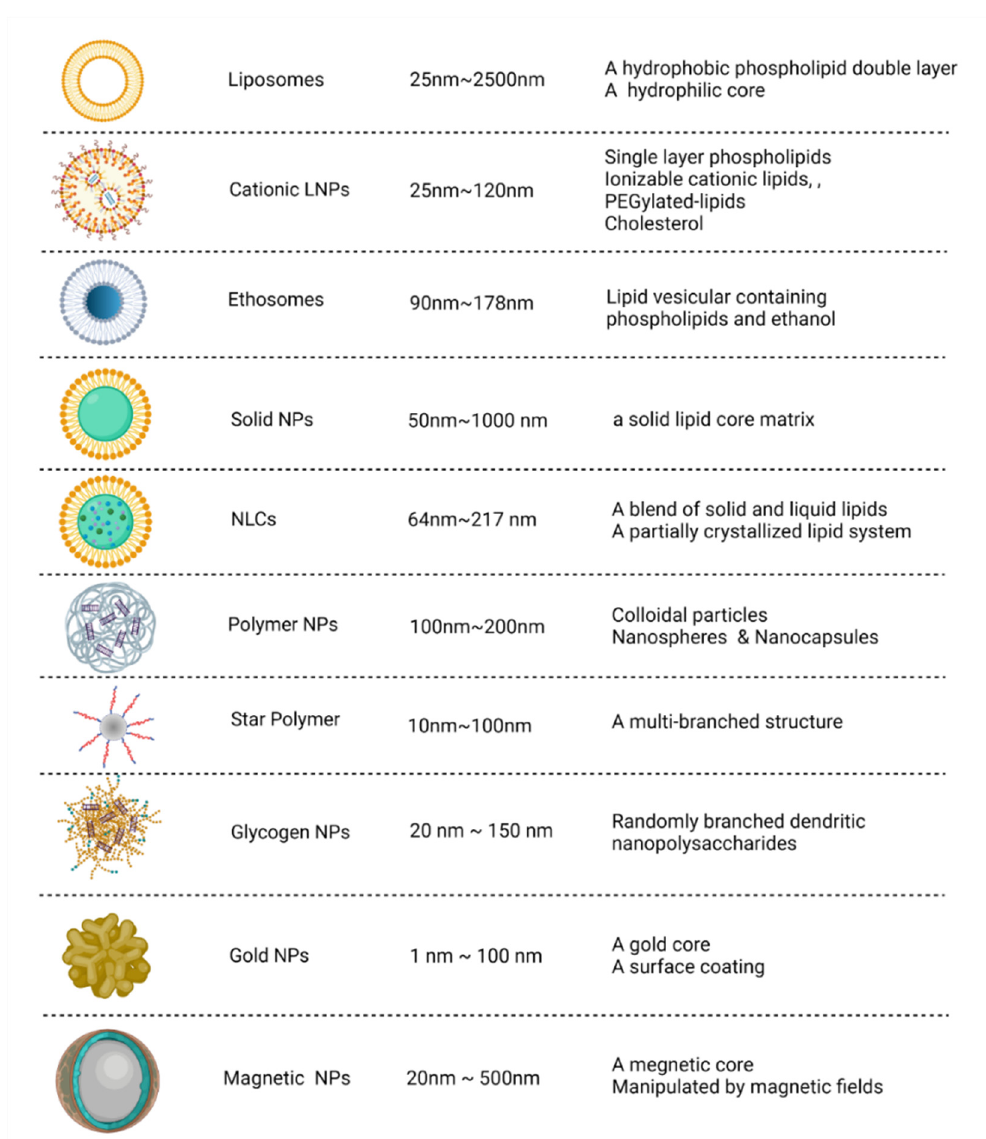
Figure 2. Comparison of different nanocarriers. Advanced nanocarriers can be divided into organic NPs (lipid NPs, polymers NPs, and glycogen NPs) and inorganic NPs (gold NPs and magnetic NPs) according to their size, structures, and characteristics. NPs, nanoparticles; NLCs, nanostructured lipid carriers; LNPs, lipid nanoparticles. Created with BioRender.com.